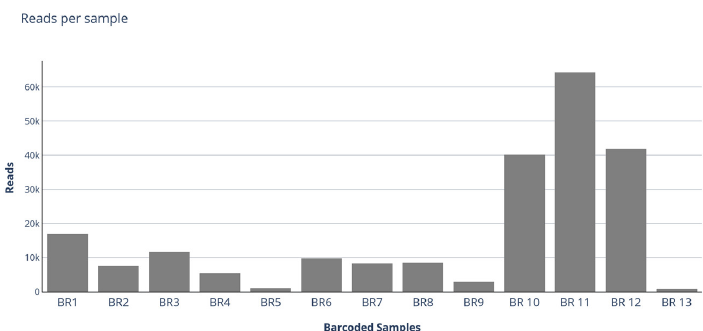
Figure 1. Histogram with the read number per sample. BR7, BR8 and BR9 each contained 3 or 4 pooled samples (11 samples in total).